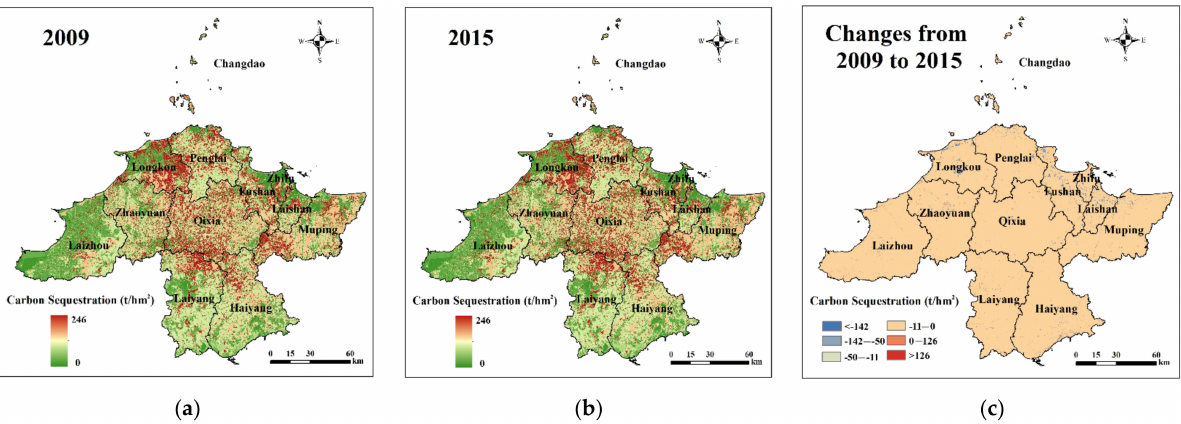
Figure 4. ( a ) Spatial distribution of carbon sequestration in Yantai in 2009; ( b ) spatial distribution of carbon sequestration in Yantai in 2015; ( c ) changes of carbon sequestration in Yantai from 2009 to 2015.